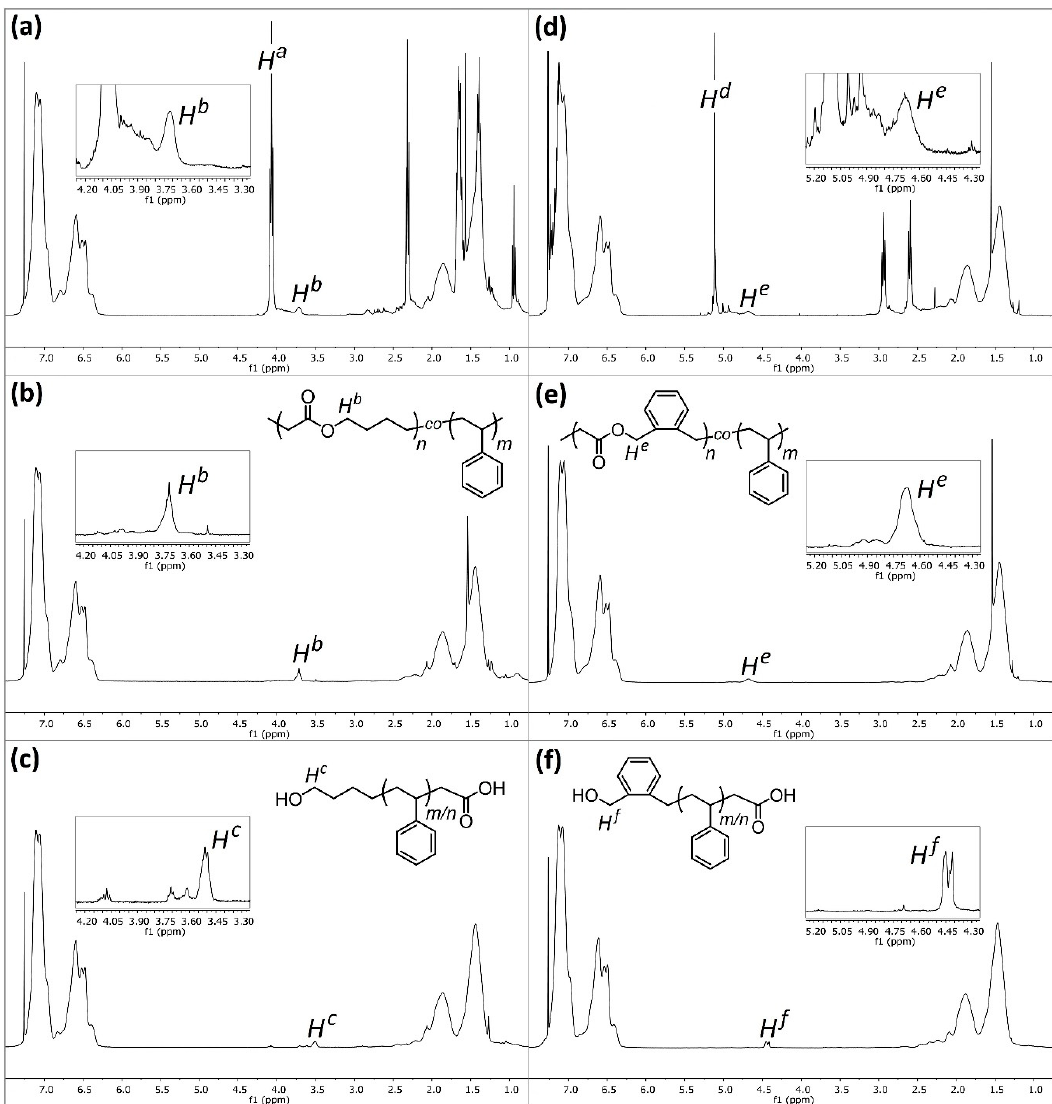
Figure 4. The 1 H NMR (CDCl 3 ) spectra of (a) P4 , (b) P6 , (c) degraded oligomers of P6 , (d) P10 , (e) P11 and (f) degraded oligomers of P11 .